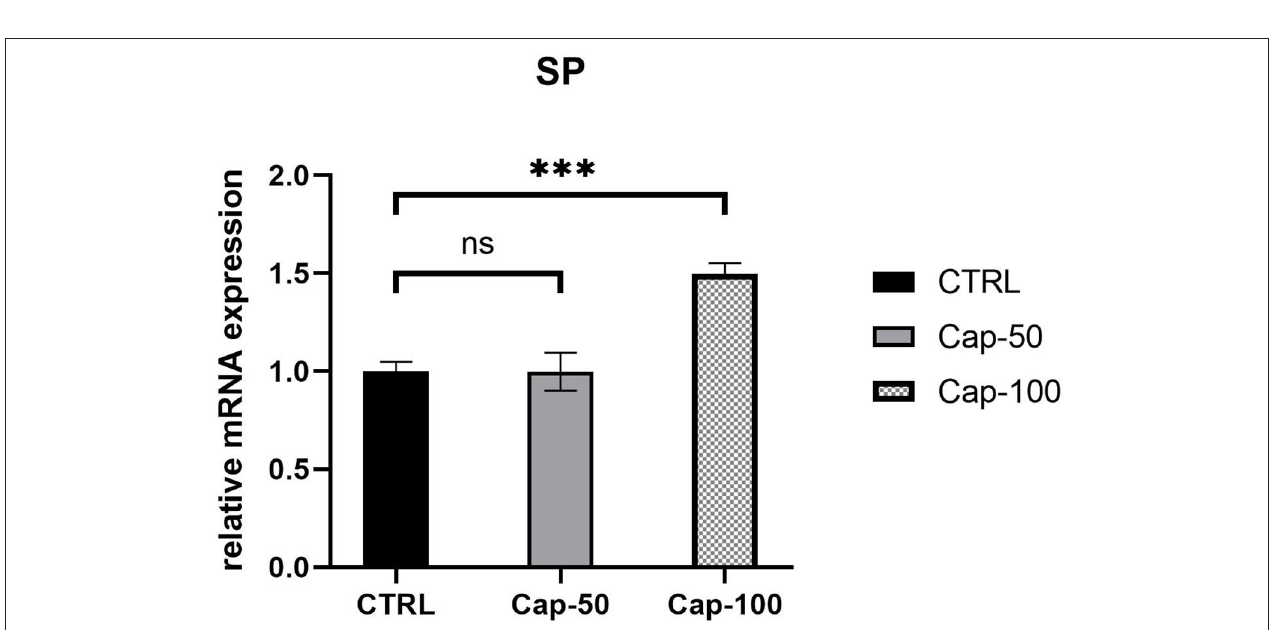
FIGURE 7 | Relative mRNA expression of serum SP 1 week after the subcutaneous injection of 50 or 100 mg/kg capsaicin. The results are represented as the mean of 3 experiments ± SD, which were performed in duplicate for each experimental condition (ns P ≥ 0.05; *** P <